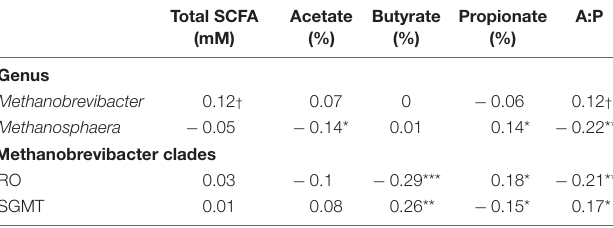
TABLE 6 | Correlation coefficients amongst rumen methanogens with rumen fermentation characteristics.